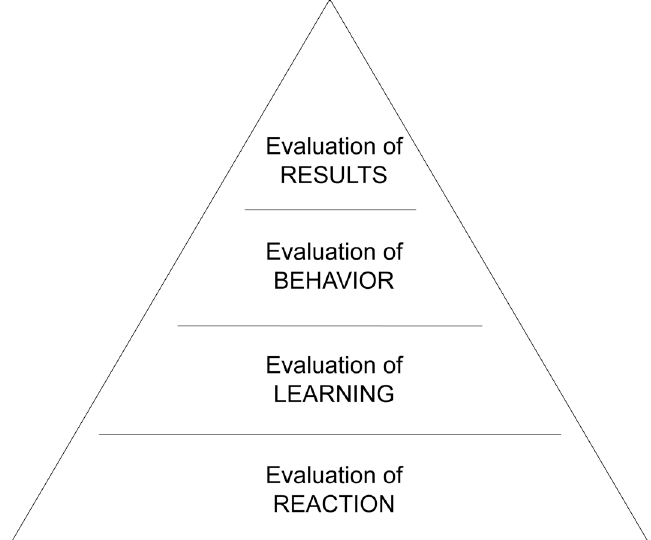
Figure 2. Kirkpatrick’s model for learner